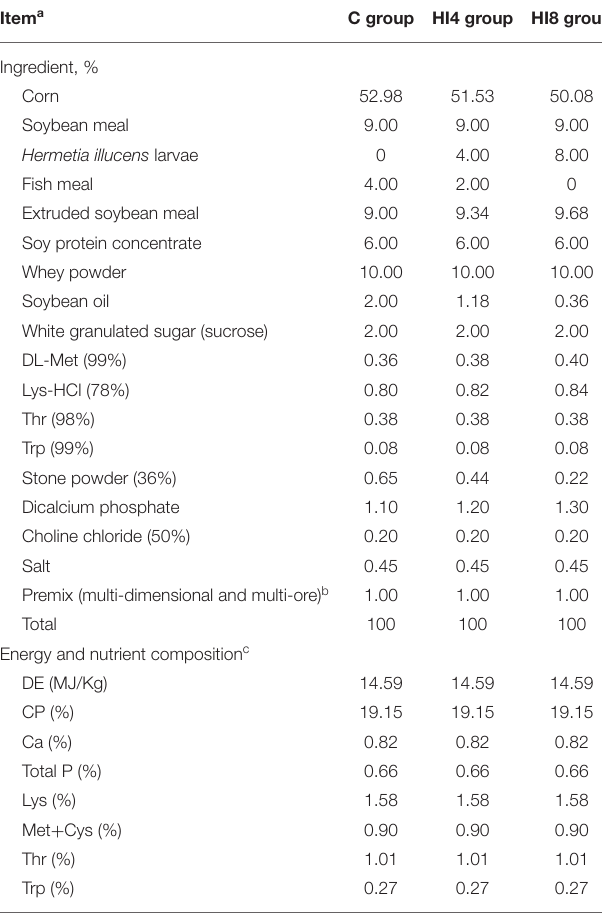
grade score of diarrhea was as follows: solid = 0, semisolid = 1, semiliquid = 2 and liquid = 3 (19). Diarrhea index is the sum of repeated fecal scores during the trial period / total number of repeated feeding during the trial period. The number of piglets with diarrhea was determined and used to calculate the incidence of diarrhea, i.e., the ratio of the number of piglets with diarrhea to the total number of